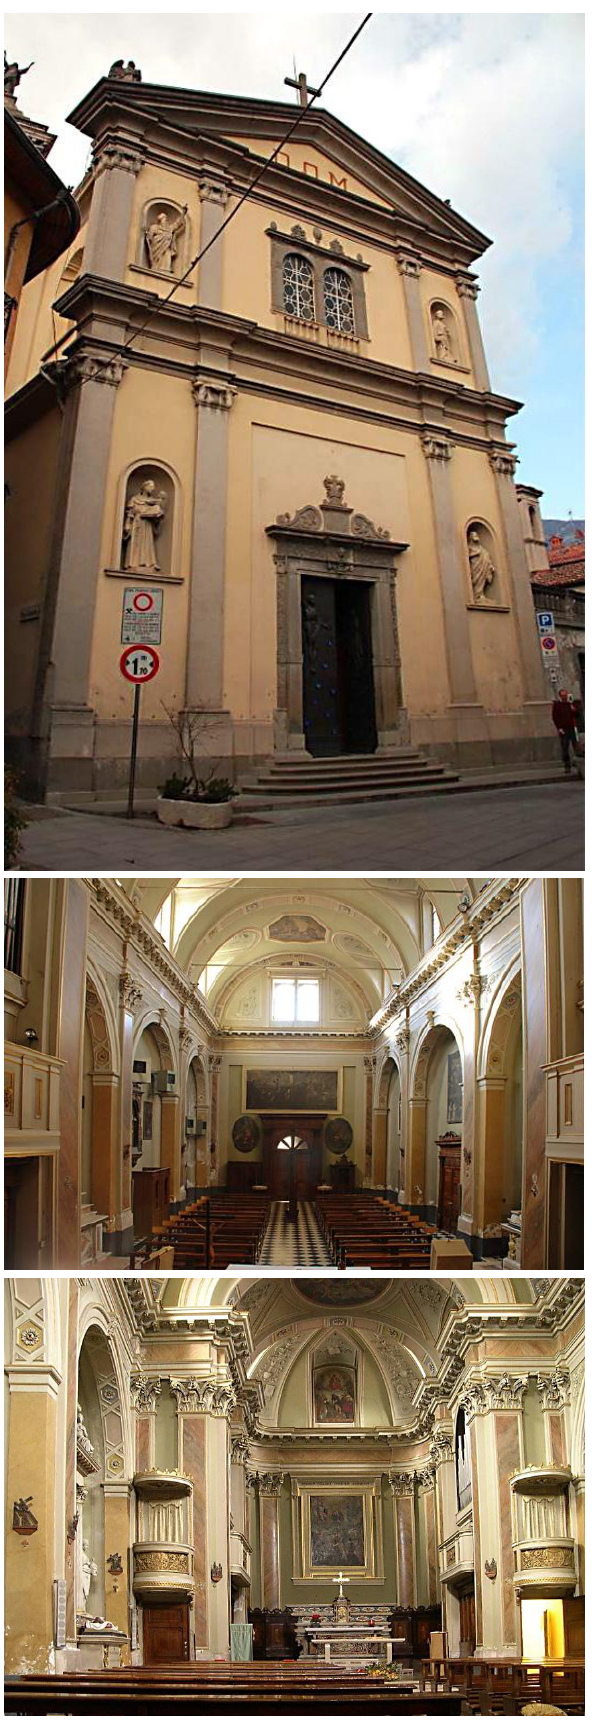
Figure 12. Scanning operations Figure 10. The church: the façade and the